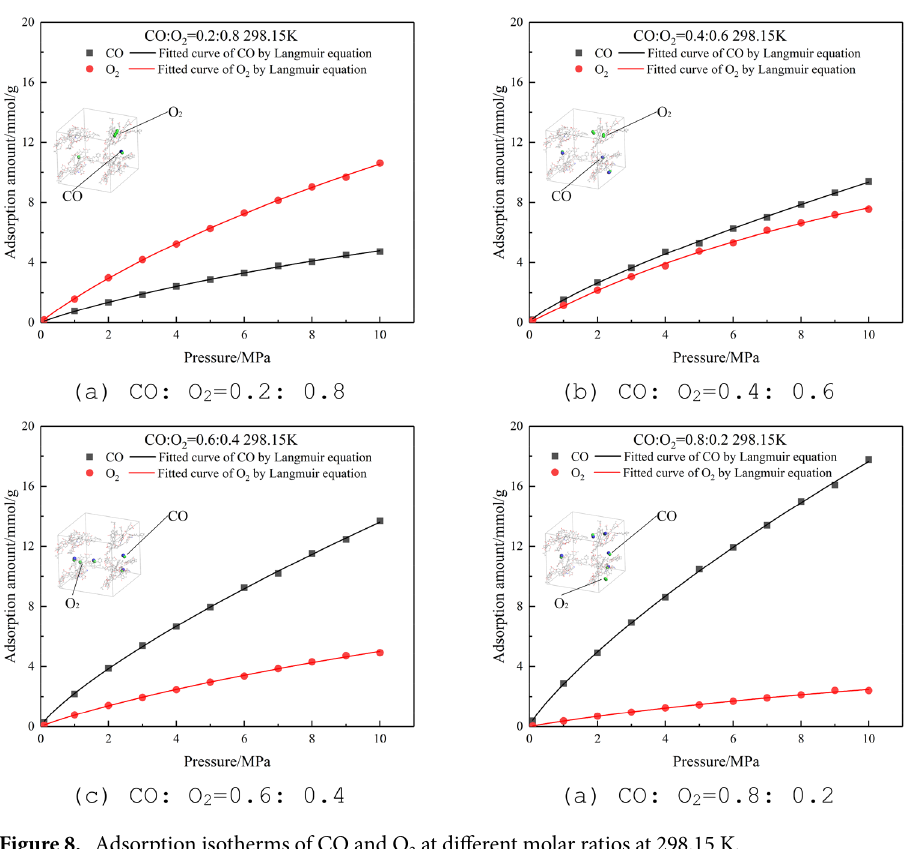
Figure 8. Adsorption isotherms of CO and O 2 at different molar ratios at 298.15 K.